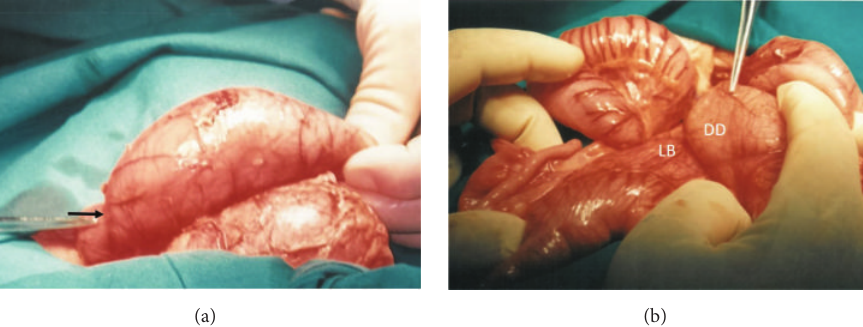
Figure 3: (a) Entry point of ileocolic intussusception (black arrow). (b) Ladd’s bands (LB) with dilated duodenum